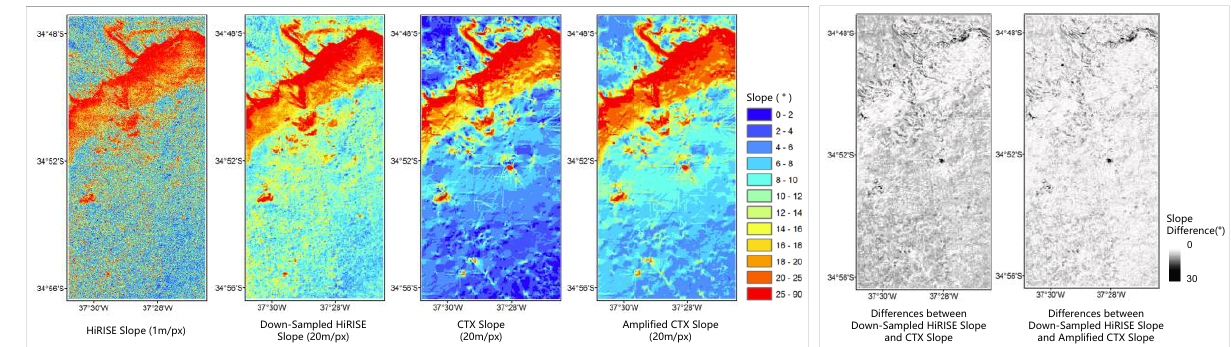
Figure 6. Verifications between HiRISE data and CTX data